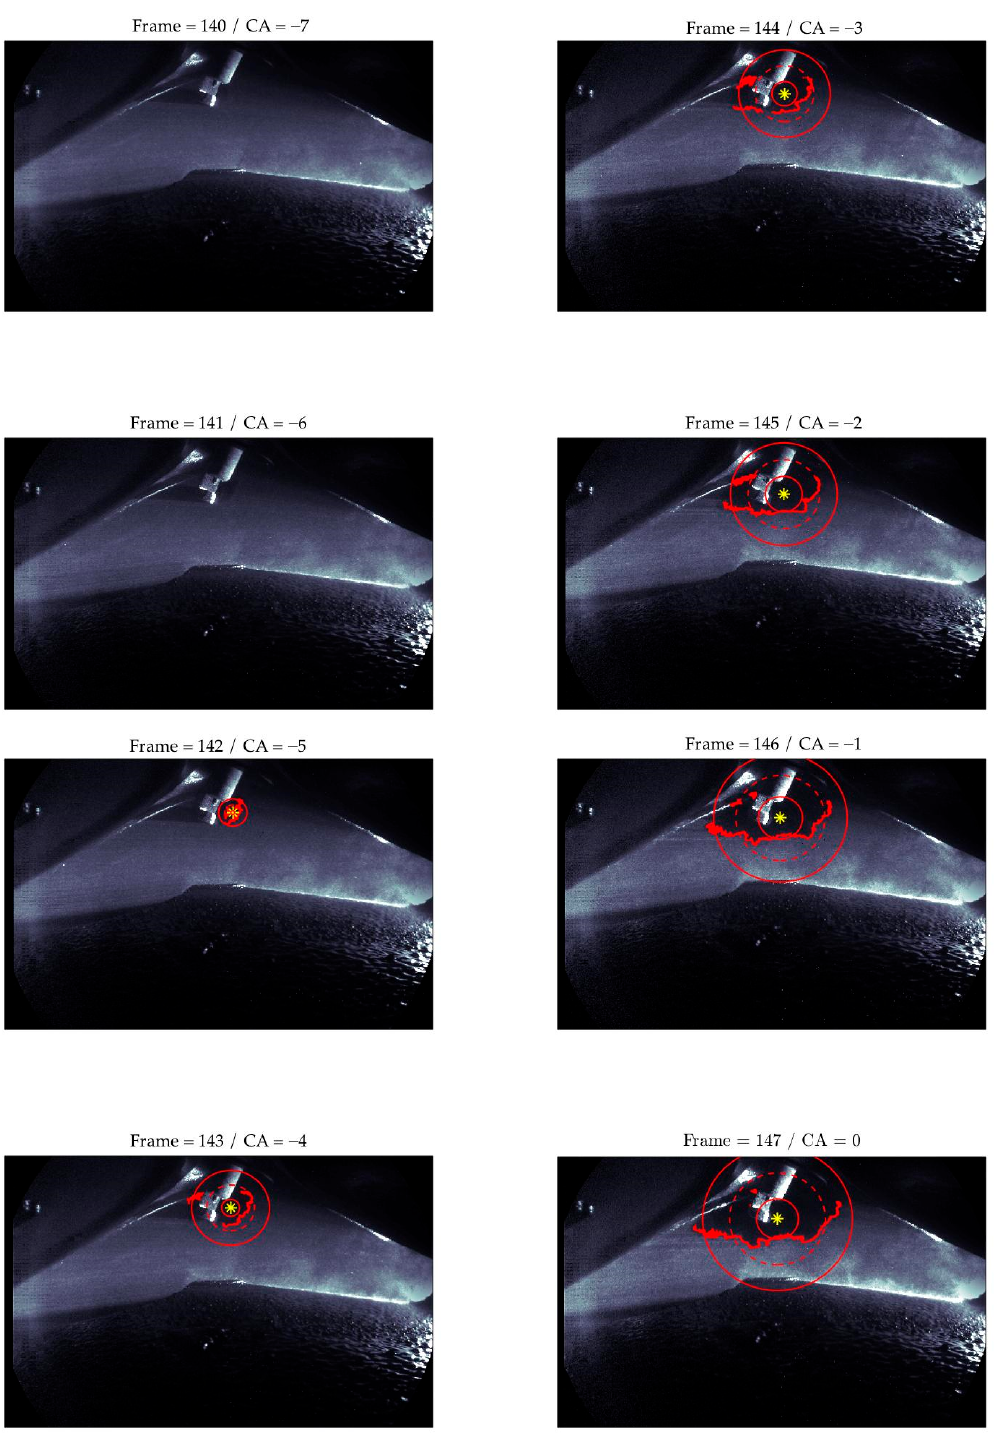
Figure 15. Cycle 60. Background corrected images of turbulent flame from − 7 CAD to TDC firing. Superimposed geometric properties: flame edges, flame center, min, max, and average radii. Engine operation: 1000 RPM, wide open throttle.